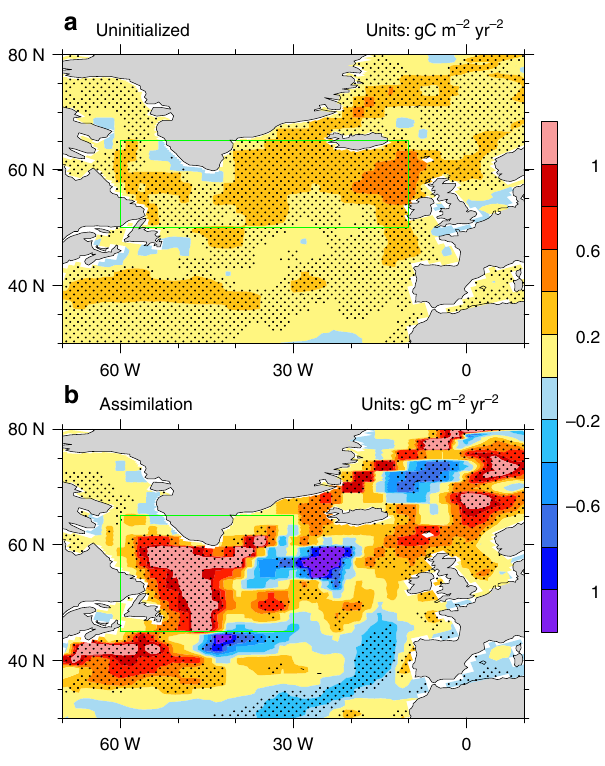
Figure 1 | Trends of annual mean CO 2 flux into the ocean from 1970 to 1995. Ensemble mean of uninitialized simulations ( a ) and assimilation simulation ( b ) (units: gCm (cid:2) 2 per year 2 ). The trends are calculated based on linear regression. The dots show grid points where the trends are significant at 95% level, based on a two-sided t -test. The green box in a denotes the SPG region where the mid-1990s abrupt warming occurred 11 , and the green box in b denotes the western SPG region where the CO 2 flux increases the